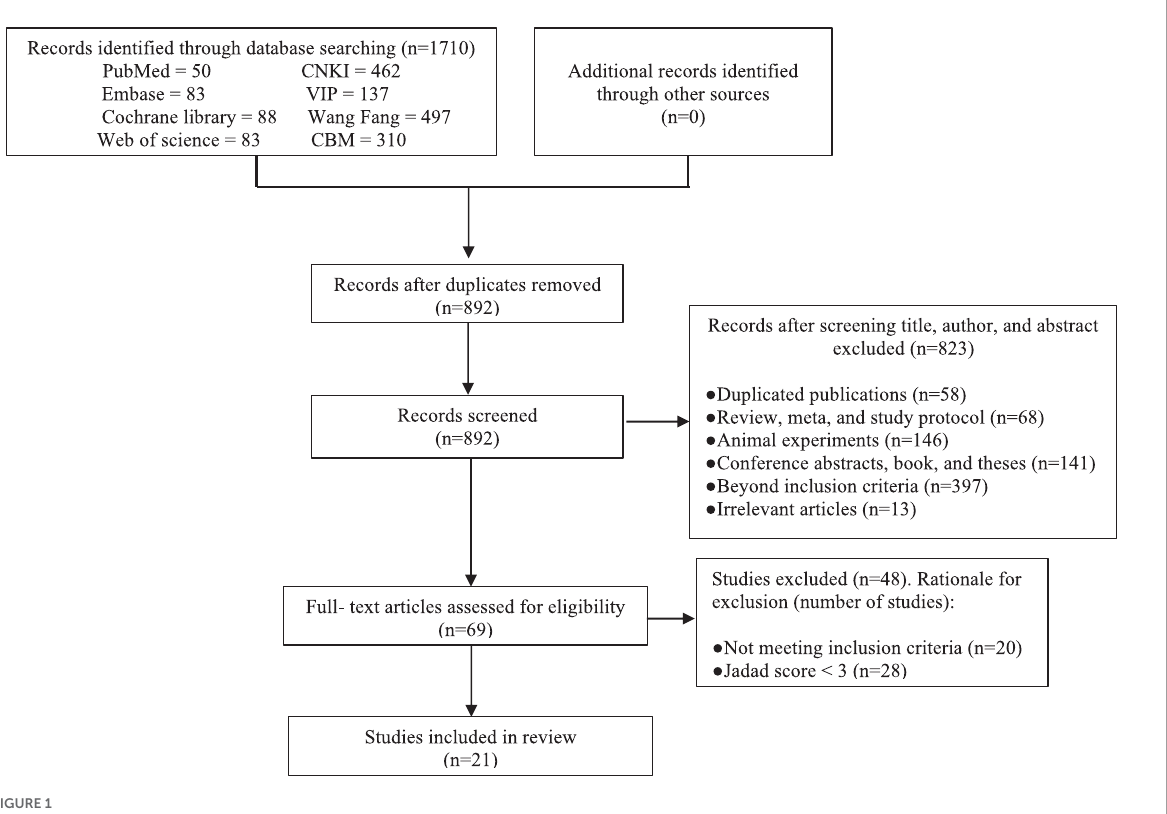
FIGURE1 Flow chart of study selection